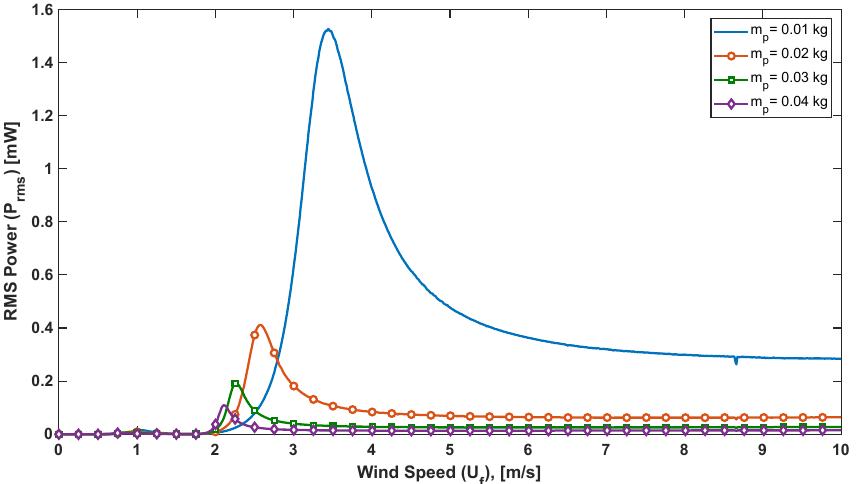
Figure 7. The effect of m p on the harvester power and bandwidth as it changes from 0.01 kg to 0.04 kg.